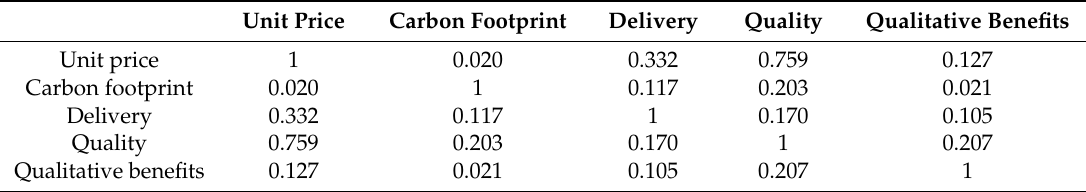
Table 6. Pearson correlation